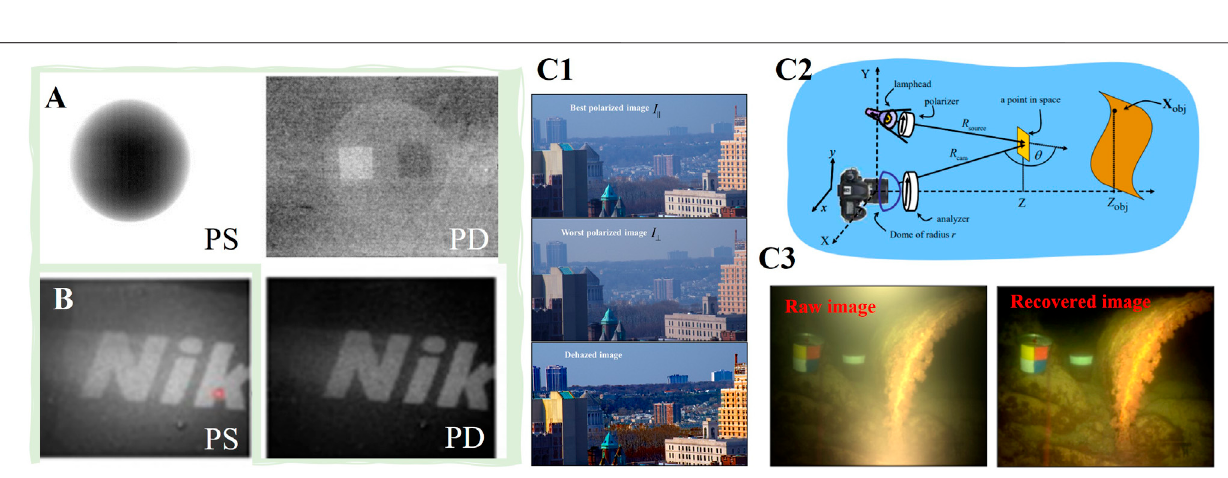
FIGURE 4 | The comparison results by (A) Tyo ’ s imaging method (reprint from OSA: Applied Optics [41], copyright 1996) and (B) Guan ’ s methods (reprint from OSA: Optics Express [42], copyright 2013). (C1) Imaging recovery example in air-environment (reprint from OSA: Applied Optics [32], copyright 2003), (C2) and (C3) underwater based on Schechner ’ s model (reprint from IEEE: Transactions on Pattern Analysis and Machine Intelligence [35], copyright 2008).